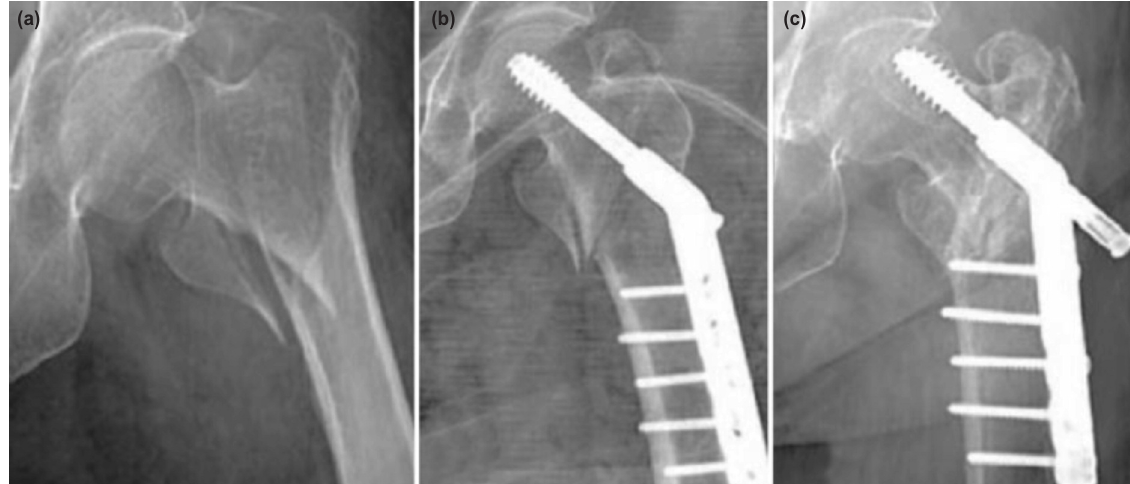
(a) Anteroposterior pre-operative, (b) Post-operative and (c) Final follow-up radiographs showing an unstable intertrochanteric Fig. 2: fracture fixed with